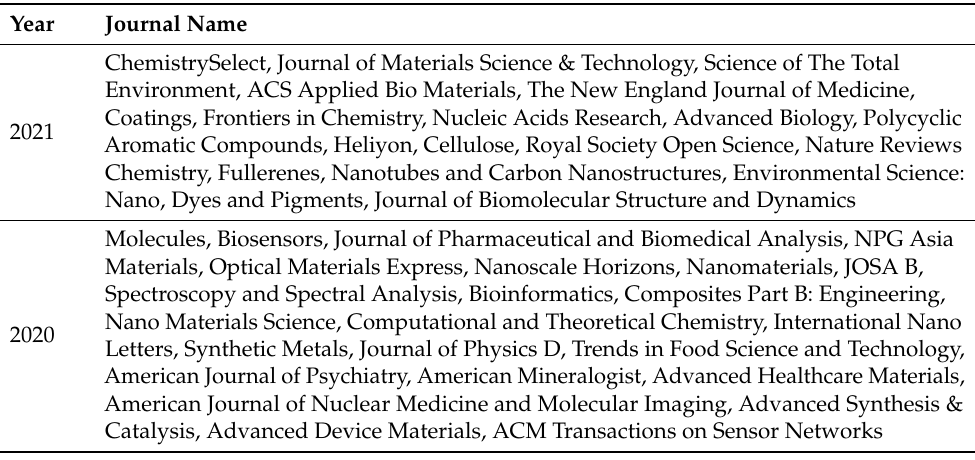
Table 2. A list of journals has appeared in the co-occurrence network over the last two